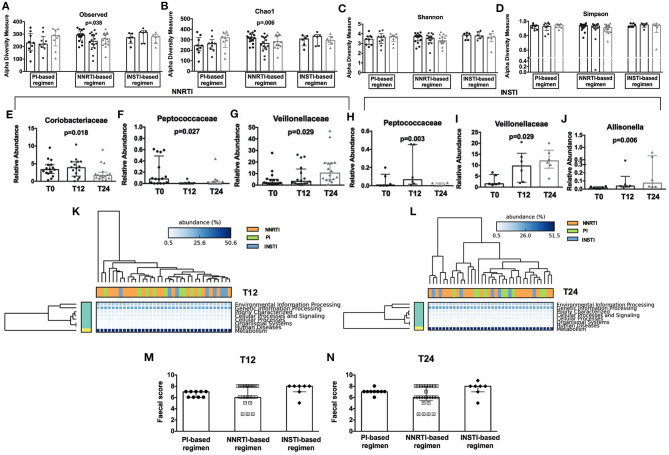
Fecal alpha diversity indexes, relative abundance analyses, metagenomic prediction, and gut persistence score according to cART class. Comparison of alpha diversity measures in HIV-infected patients during cART (3 bars, from left to right: T0, T12, and T24) subdivided according to different cART regimens presented according to Observed (A), Chao1 (B), Shannon (C), Simpson (D) at OTUs level. (E–J) Comparison of fecal relative abundance taxa according to cART regimens analyzed Friedman test, p-values not adjusted for multiple comparisons. (K,L) Predicted metagenomic functions according to class cART. Data analyzed by Welch's (uncorrected) 0.95 for post-hoc test, and Bonferroni correction. (M,N) No differences were found in terms of fecal Gut Persistence Score according to class cART in the course of the study analyzed by Friedman test, p-values are not adjusted for multiple comparisons.